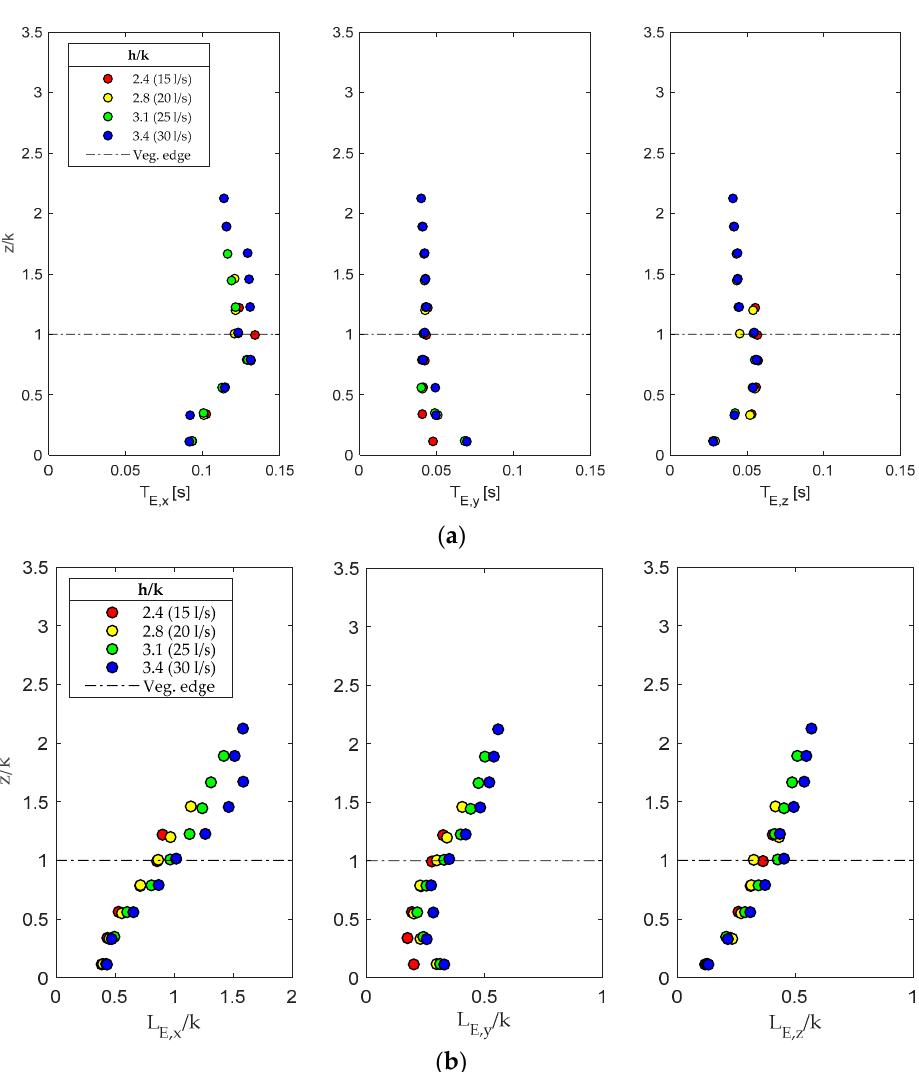
Figure 12. Profiles of integral scales of the flow: ( a ) Eulerian integral time scales; ( b ) Eulerian integral length scales.